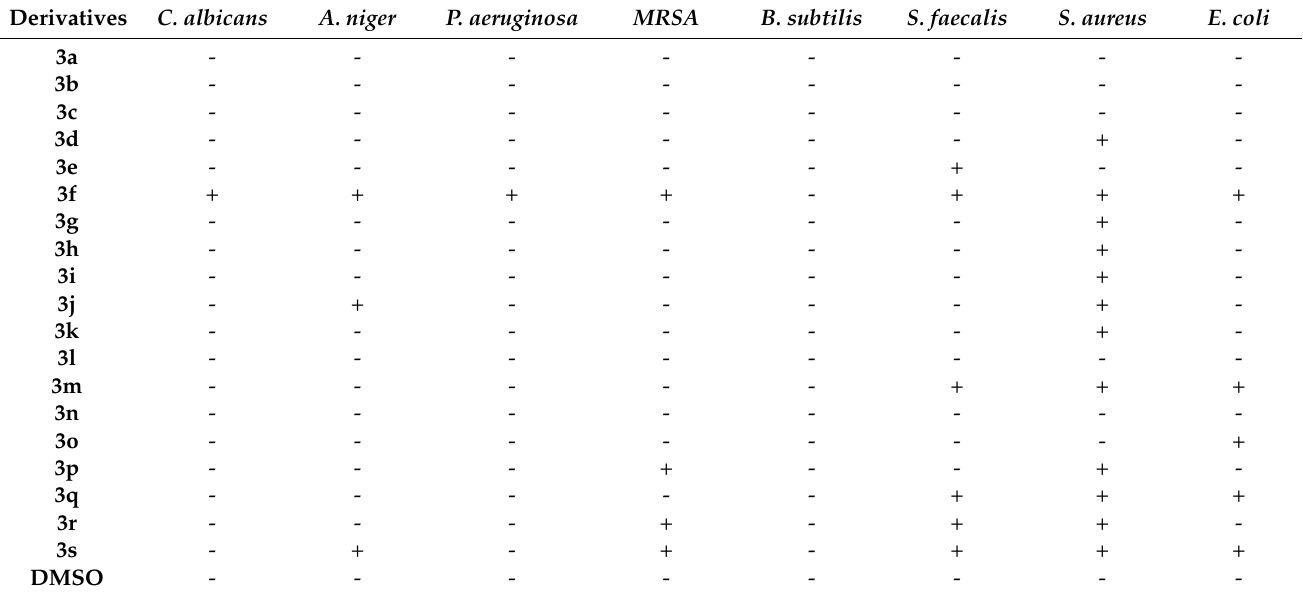
Table 4. Results of the antifungal and antibacterial effects of the